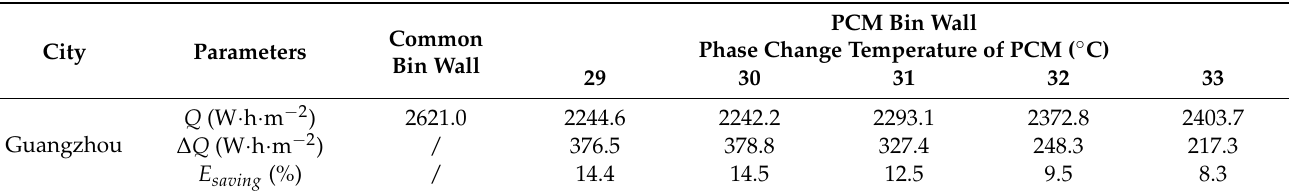
Table 2. Weekly heat gain and energy saving results with different Tm for hot grain storage region.